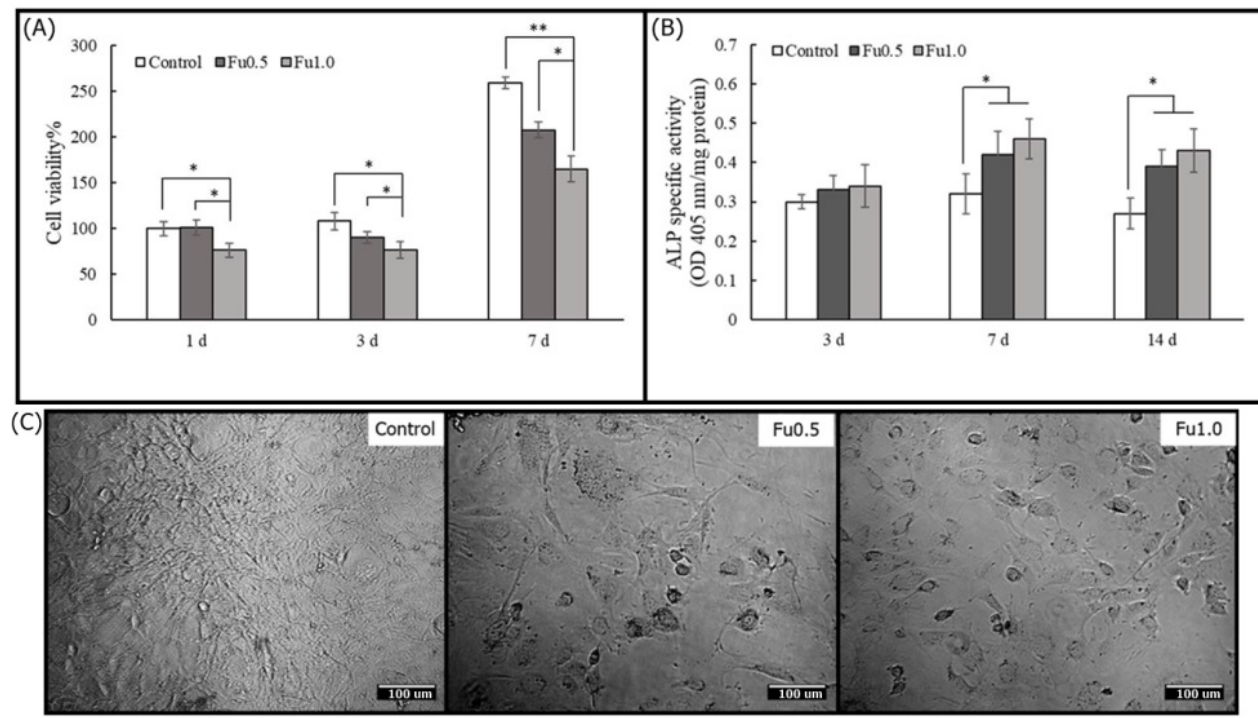
Figure 6. The cell viabilities ( A ) and ALP-specific activities ( B ) of Fu with MG63 cells in plate culture on Days 1, 3, and 7 and the cell morphology on Day 7 ( C ). The normalization was based on the viability of cells cultured on MEM medium (control). * ( p < 0.05) and ** ( p < 0.01) indicate the level of significance. Scale bar = 100 μ m.